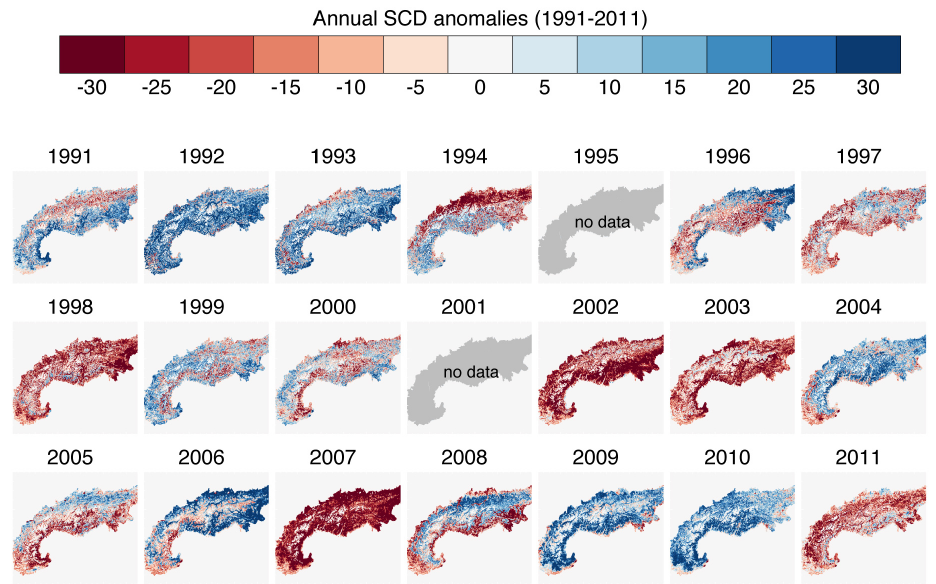
Fig. 8. Annual departures from the long-term mean (1991–2011) given in days. Years refer to January 1. The data coverage in 1995 and 2001 was insufficient for the application.